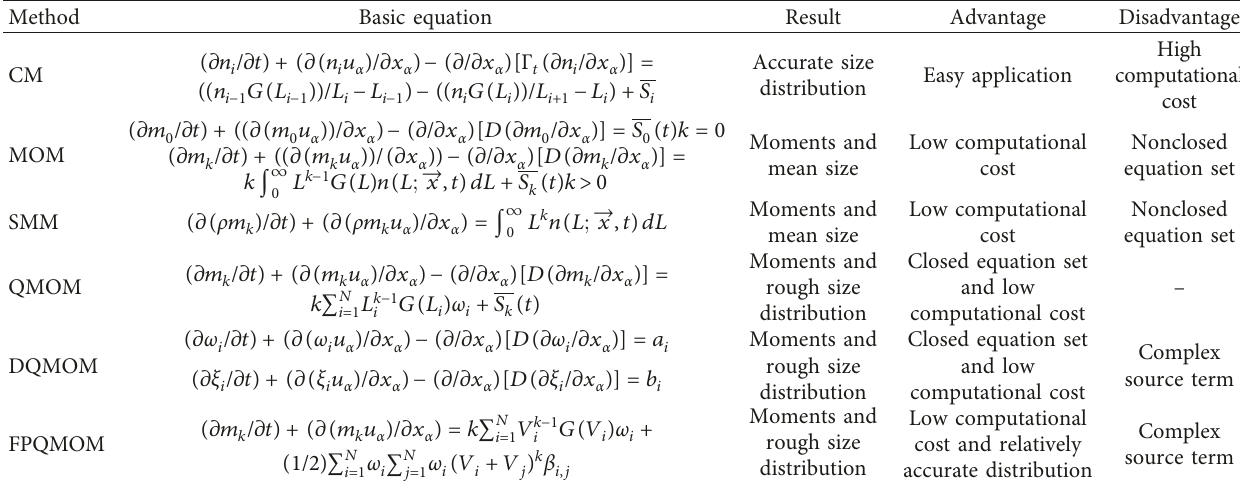
Table 1: The numerical methods for PBM